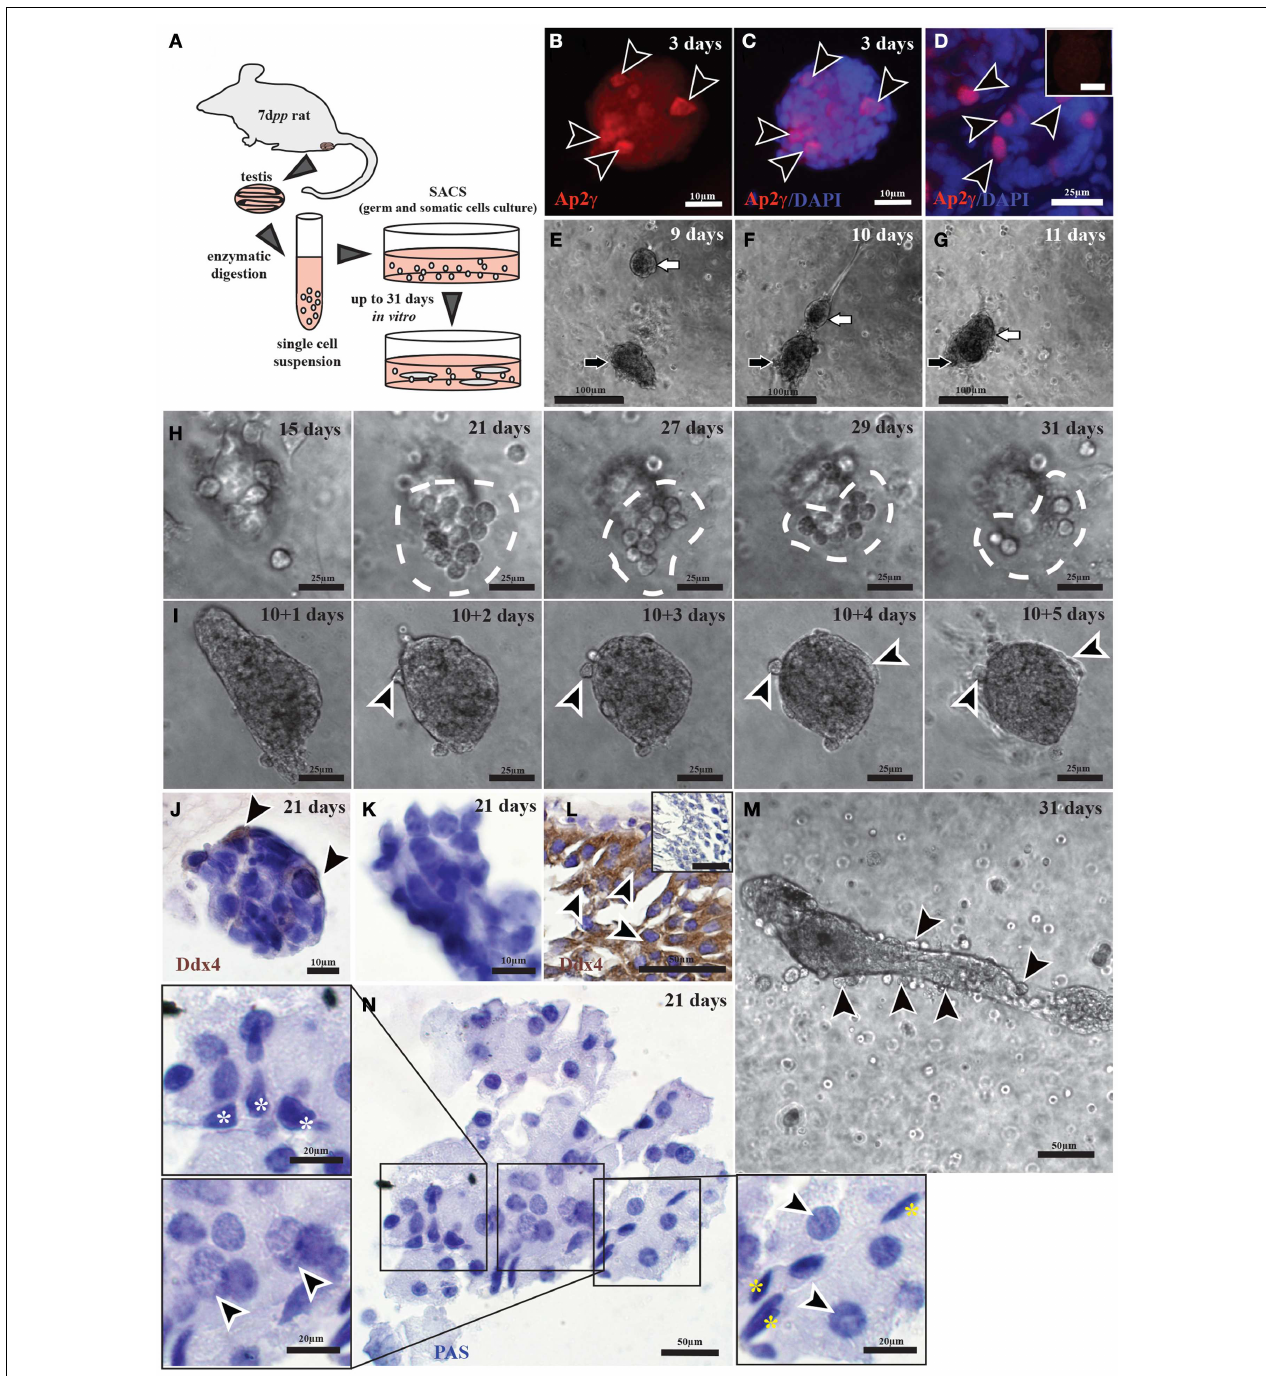
colonies cultured for as long as 31days [white dashed line in (H) , black arrows heads in (M) ] or following incubation of isolated cell colonies in liquid medium for 5days [black arrow heads in (I) ]. (J–L) Immunohistochemical staining for germ cells (Ddx4) in colonies originating from 7-day-old rats and cultured for 21days (J,K) , as well as from 60-day-old rat testis [positive control; (L) ] [Ddx4: brown staining (black arrow heads); Hematoxylin: blue staining]. (N) Cells cultured for 21days exhibit morphologies similar to those of peritubular cells (yellow stars), Sertoli cells (white stars), leptotene spermatocytes, and early pachytene spermatocytes (black arrow